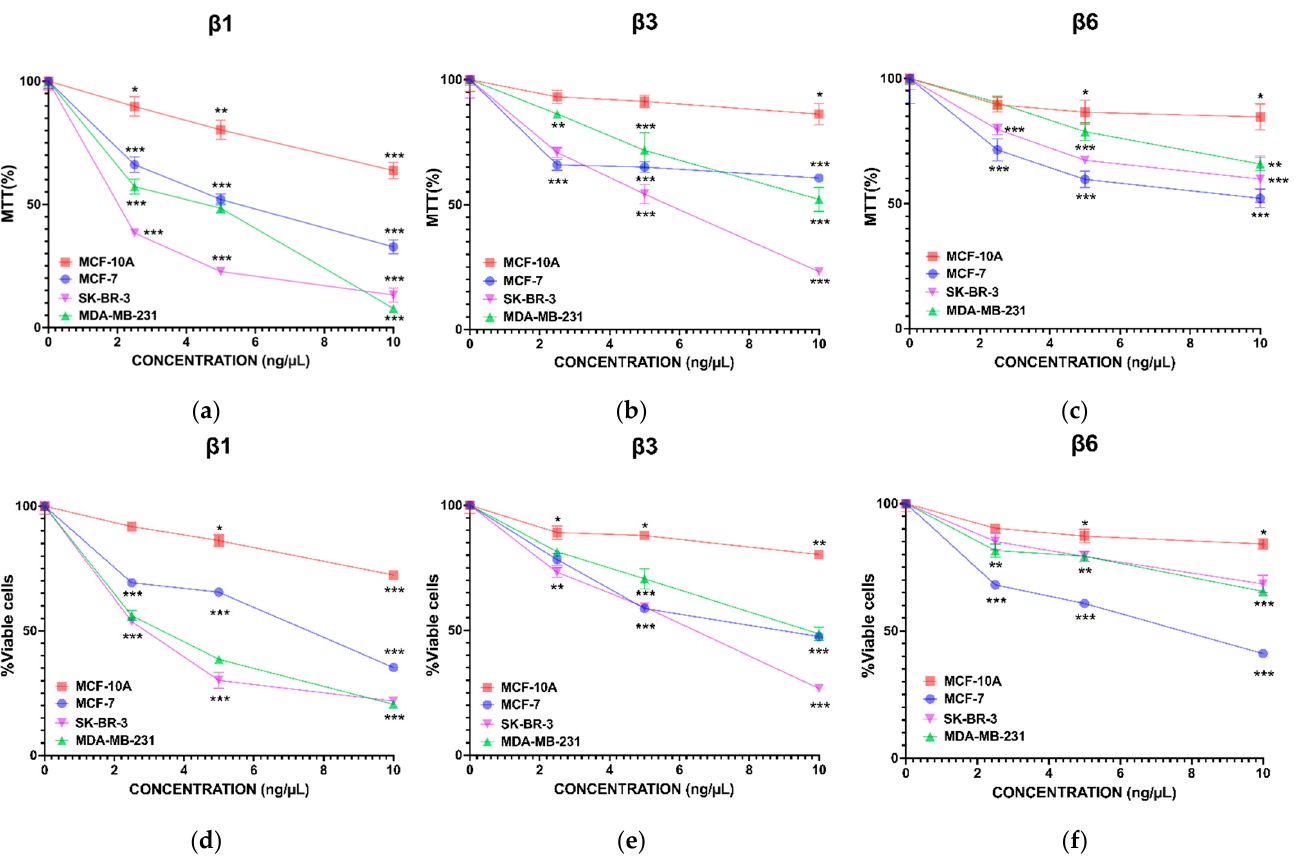
Figure 1. Inhibition of cell growth by β -conglutins in a BC model in vitro. Cells were seeded in 96-well plates at a density of 3 × 10 3 cells per well. After 72 h of ( a ) β 1, (b) β 3, and ( c ) β 6-conglutin treatment, 10 µL of 5mg/mL MTT was added to each well. Absorbance was determined 4 h later for all types of cells. In other experiments, after 72 h of ( d ) β 1, ( e ) β 3, and ( f ) β 6-conglutin treatment, a trypan blue assay was performed to determine the cytotoxicity of treatments versus control (non-treated cells). * p < 0.05, ** p < 0.01, and *** p < 0.001 vs. non-treated